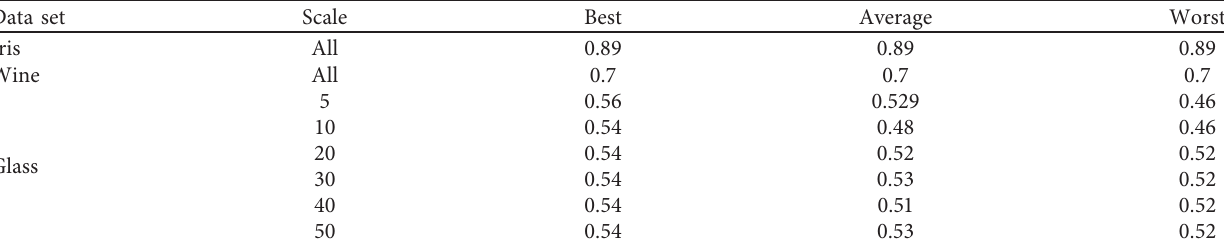
Table 3: The influence of remote sensing image clustering